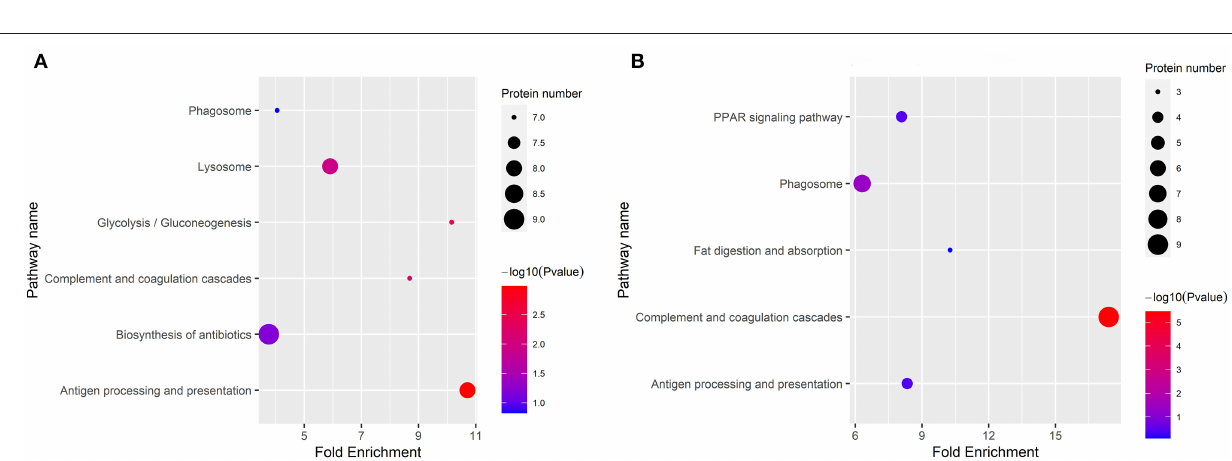
membranes. Breastfeeding protects infants against